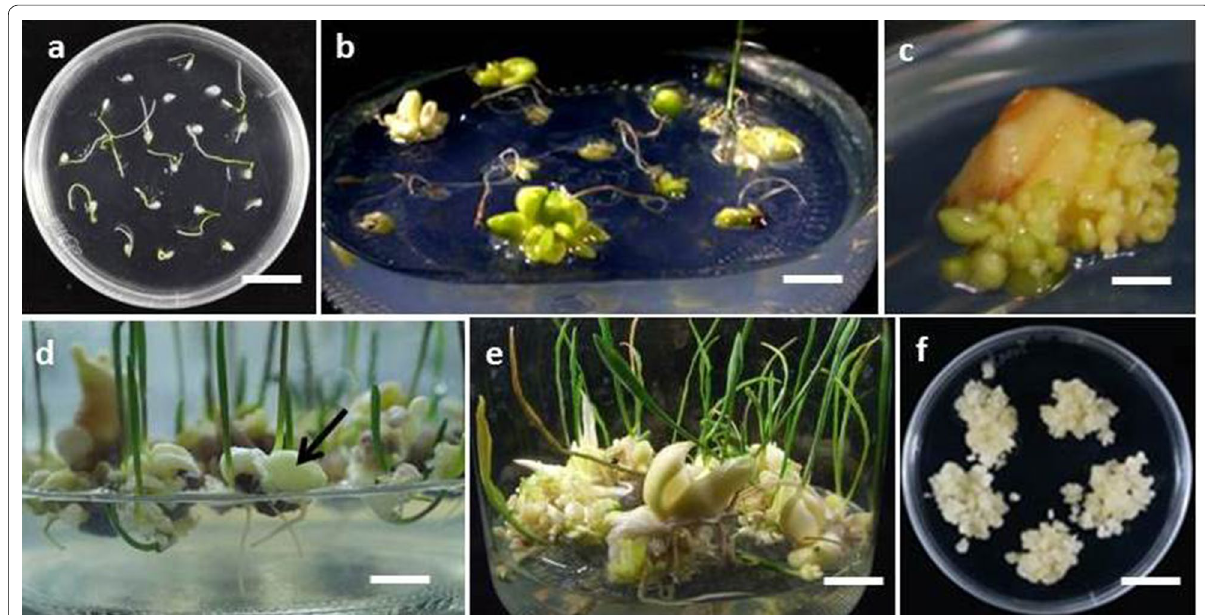
Fig. 2 F. cirrhosa : a : In vitro seed germination on MS basal medium supplemented with BA (1.0 mg L − 1 ), NAA (0.4 mg L − 1 ) after incubation for 20 days (bar 1.8 cm). b : Bulblet and callus formation in 4 month old seedlings growing on 1/2X MS basal medium supplemented with sucrose = (2.5%), GPP (0.4%) (bar 1.24 cm). c , d , e : Bulblet regeneration from bulb sections after 2 months of culture ( c , bar = subculture 2 (6 months) ( d , bar 0.9 cm, arrow showing a bulblet); and at the end of subculture 5 (12 months) ( e , bar = under darkness (bar 1.8 cm) =